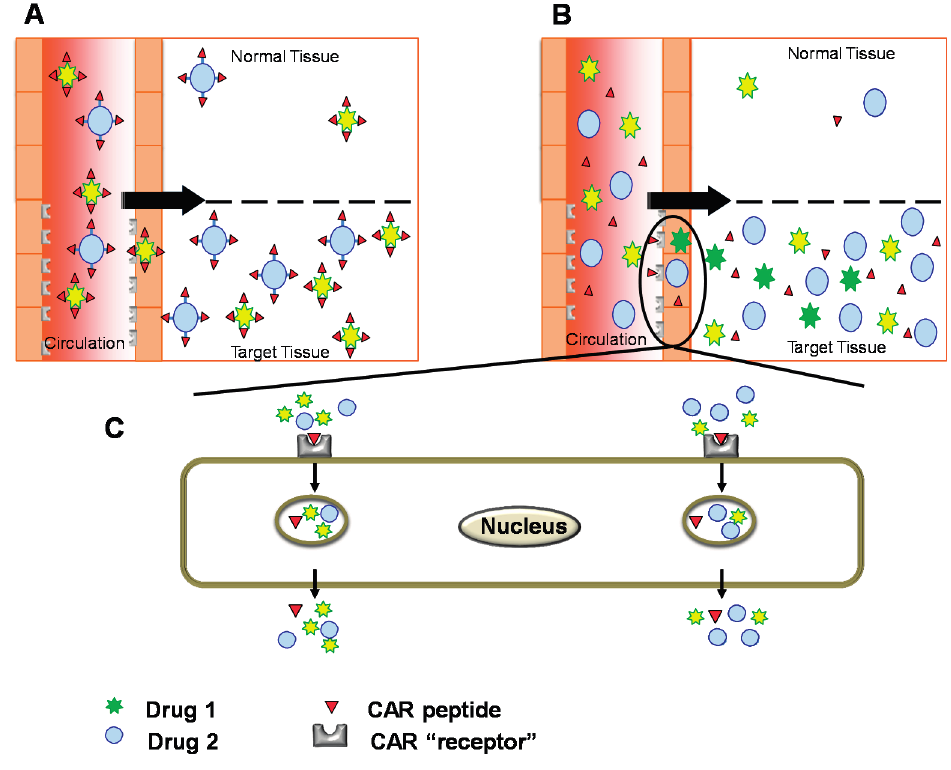
Figure 3. Systemically administered, targeted therapies: ( A ) The drugs are conjugated physically to the targeting device in conventional drug targeting. For protein-based therapeutics, targeting domain and therapeutic molecule are fused together as a recombinant protein with enhanced activity and tissue-specificity in conjugated delivery; ( B , C ) Bystander effect: Compounds co-injected with tissue-penetrating homing peptides are transported across the vessel wall and through tissue together with the peptides [12,42–45]. No physical conjugation is needed between the targeting peptide and drug; the cell penetrating homing peptide “sweeps” co-injected drugs to its target (homing) tissue in tissue-specific fashion [12,42,45]. One of the benefits of using short peptides as targeting elements, is that the peptides are unlikely to be immunogenic in themselves because they are simply too small. For example, they are a fraction of the size of the highly variable complementary determining regions (CDRs) of therapeutic antibodies, which generally have an excellent drug safety and low immune reaction record [10]. Furthermore, when analyzing the homology of homing peptides (by BLAST), these short and stable cyclic peptides typically show high levels of homology to parts of native proteins found across a range of species indicating that the functional domain in the homing peptide is conserved between species (as is the case for both CRK and CAR, for example) [20]. This would predict high tolerance of the peptide by the immune system. These pharmacological properties highlight the importance of advancing multi-functional, systemically administered, target-seeking recombinant fusion proteins. However, unless the target of a homing peptide is known to be unimportant for function of the immune system, cell proliferation, angiogenesis, etc. , one cannot rule out the possibility of adverse effects caused by high doses of a homing peptide binding to its target receptor. Thus, it is necessary to elucidate the target and mechanism of homing peptides, and to investigate their